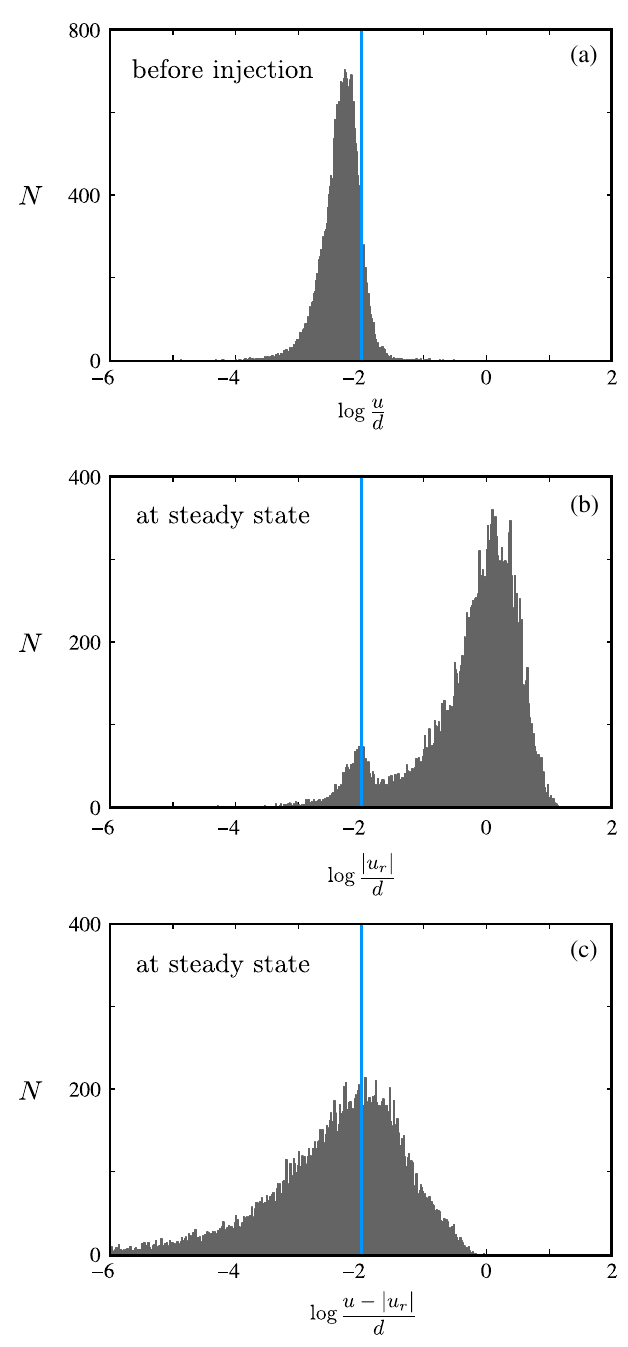
FIG. 6. We detect particle positions to within ∼ 0 . 01 d . We estimate this detection noise by calculating (a) total particle displacement between two frames taken before injection has started, when the particles are at rest. The noise has mean 0 . 006 d and s.d. 0 . 005 d , indicating a detection threshold of ∼ 0 . 01 d (vertical blue line). At steady-state deformation, (b) the average radial displacement is ∼ 1 . 4 d with s.d. 1 . 6 d and (c) the average nonradial displacement is 0 . 03 d with s.d. 0 . 06 d , indicating that particle motion is almost entirely